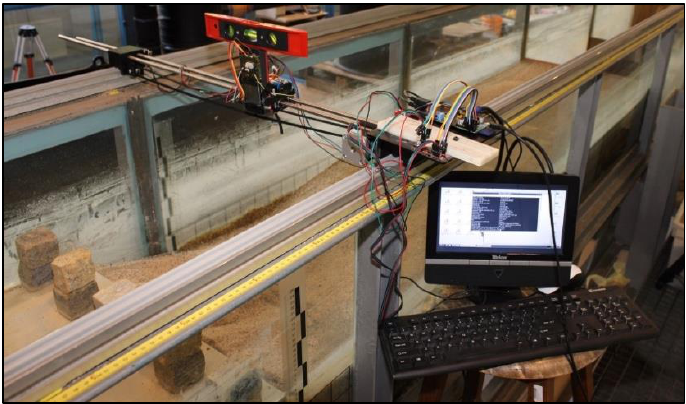
Figure 10. Laser scanner device equipped with the level—initial prototype A1.